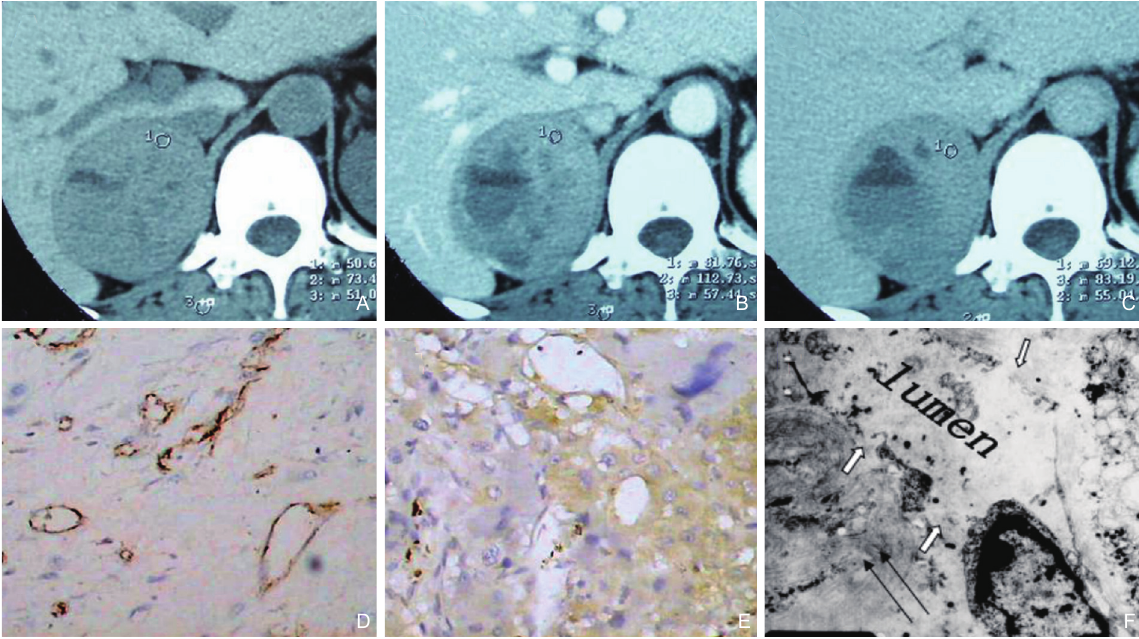
Figure 2 Right adrenal pheocromacytoma. (A-C) DCE-CT showed the slow washout with TD curve of Type B, Washr of 15%, Washa of 49% at 7-min delay timepoint; (D) MVD. Immunohistochemistry (× 200), fewer blood vessels with round lumens, showing lower MVD; (E) VEGF. Immunohistochemistry (× 200), low positive rate of cells with brown or yellow-brown granules in the cytoplasm, showing low VEGF expression; (F) Microvascular ultrastructure. Transmission electron microscopy (TEM) (× 5000) exhibited moderate to severe luminal stenosis or even near occlusion with a small sponge-like appearance, a rough luminal surface, a widening of the intercellular space, a markedly heterogeneous thickening of the basement membrane with prominent discontinuity or disappearances (empty arrow), a significantly irregular and widened extravascular space with plasma-like substances, stromal cells, and a large number of collagen fibers (double